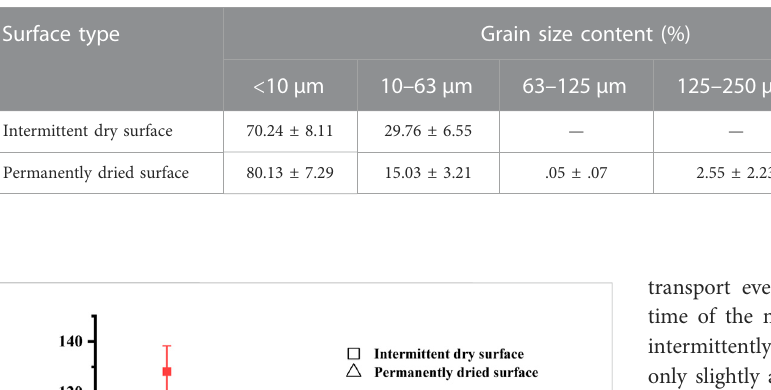
TABLE 1 Characteristics of surface soil grain size distribution and moisture content.